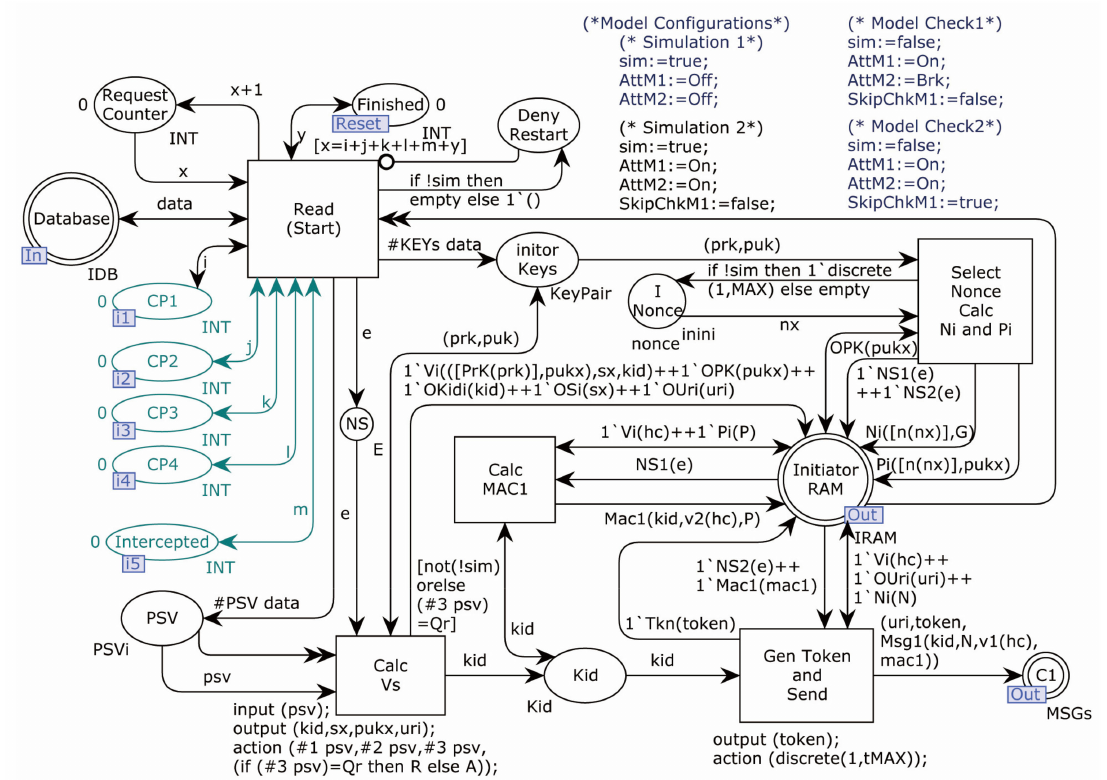
Figure 8. Initiator model sub-page